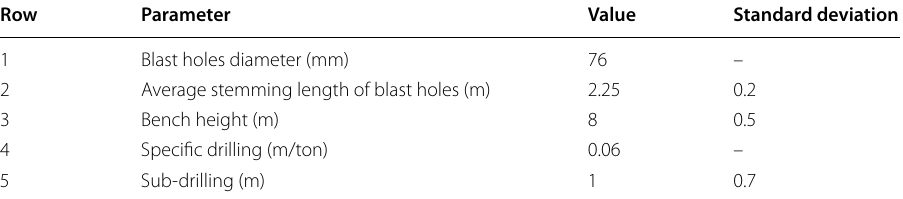
Table 1 Data on drilling patterns of three blocks